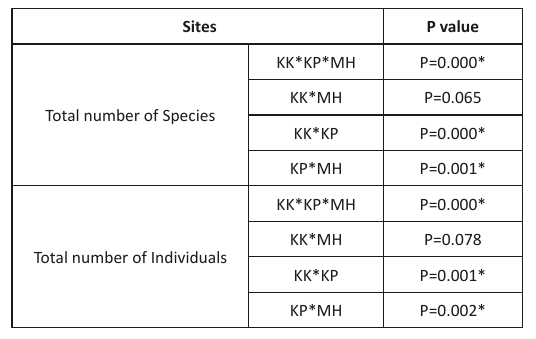
Table 2. Comparison of the total number of species and individuals of the avifauna at the three habitat